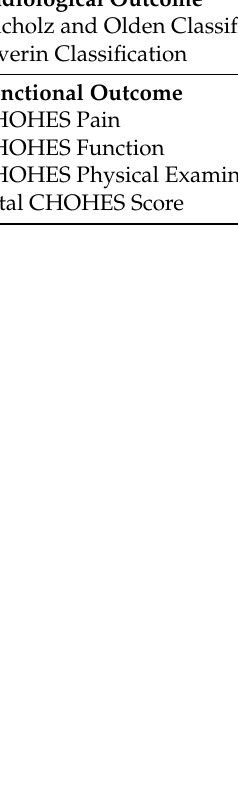
Table 4. Multivariate linear regression analysis between risk factors and measured